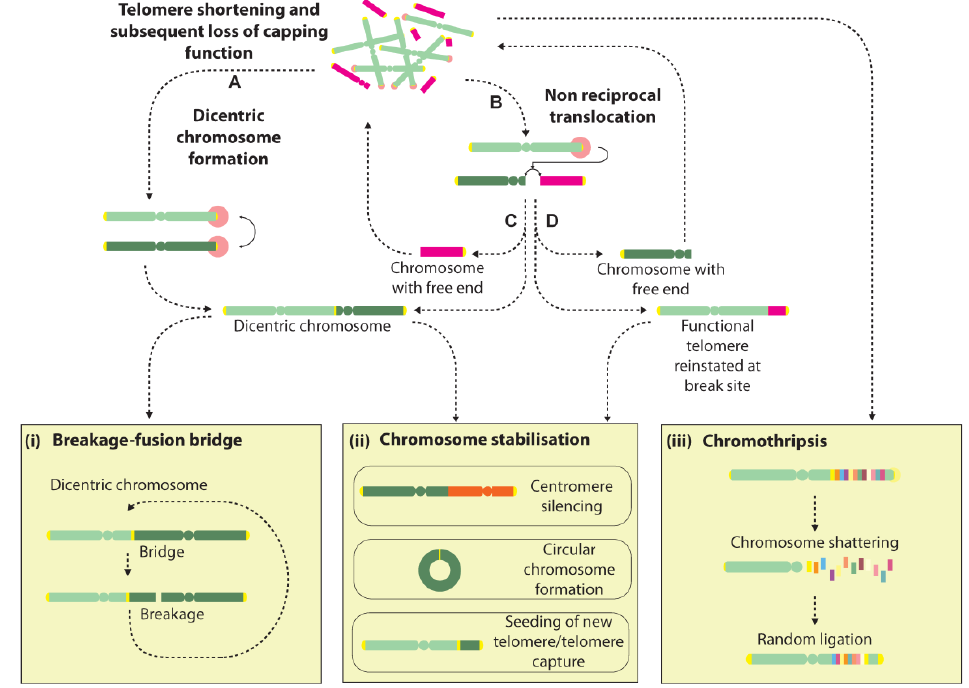
Figure 2. Cascades of genome rearrangement induced by free chromosome ends. Telomeres that lose their capping function can trigger DNA damage signalling and subsequent processing by DSB repair pathways, instigating genome instability via several mechanisms. Telomere-telomere ( A ) fusions create dicentric chromosomes that may undergo rupture during cell division, giving rise to a succession of events in a BFB cycle ( i ). Alternatively, dicentric chromosomes may be stabilised by centromere silencing ( ii ). Dysfunctional telomeres may also undergo joining with internal genomic loci giving rise to non-reciprocal translocations ( B ). Depending on the nature of the join, several outcomes are possible with examples of events given in C&D. One outcome is the formation of a dicentric chromosome plus an acentric chromosome ( C ), which may elicit further BFB events or instability by reintegration of the acentric chromosome at another genomic site. Alternatively, a functional telomere may be transferred to the initiating chromosome, at the cost of creating another free end at the participating chromosome ( D ). Chromosomes with free ends may be stabilised by circularisation, or through the seeding of a new telomere ( ii ). Recent reports suggest that telomere dysfunction may also trigger ‘all-at-once’ events such as chromothripsis, a process thought to involve the shattering and random re-ligation of chromosomes that may either give rise to a stable genomic configuration, or may promote further instability due to the presence of a free chromosome end ( iii ).